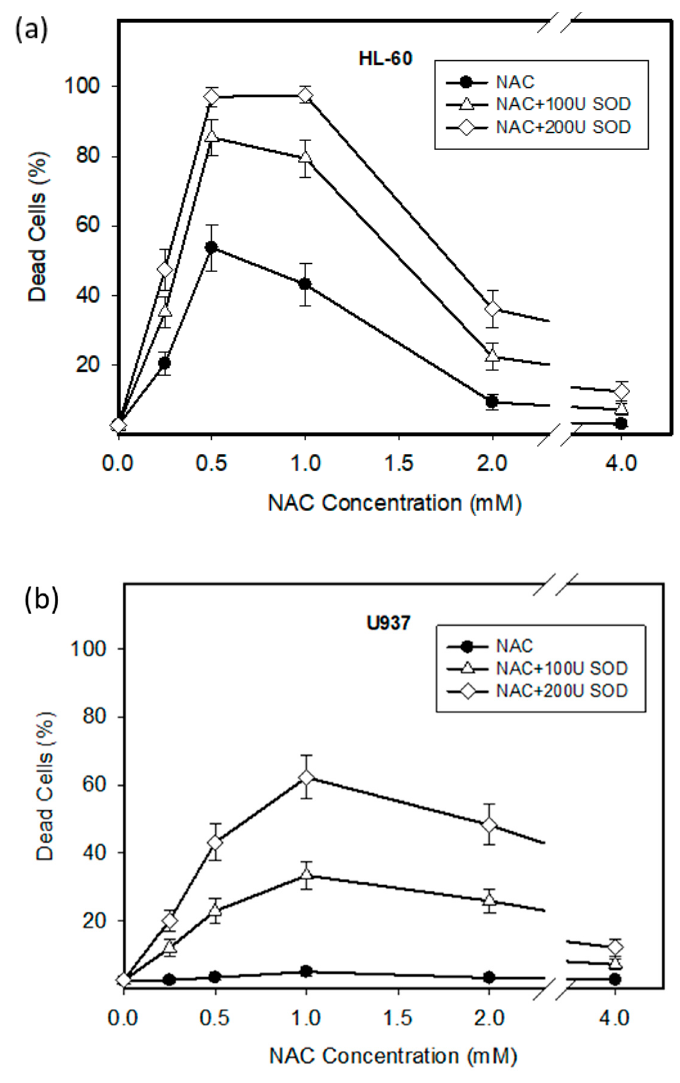
Figure 1. Effect of NAC on cell viability in HL-60 and U937 cells. Cells were treated with NAC or with NAC + SOD , as indicated. After 24 h incubation, the number of dead cells was determined using the trypan blue dye exclusion assay. ( a ) HL-60 cells. ( b ) U937 cells. The points represent the mean from three independent experiments with standard errors.